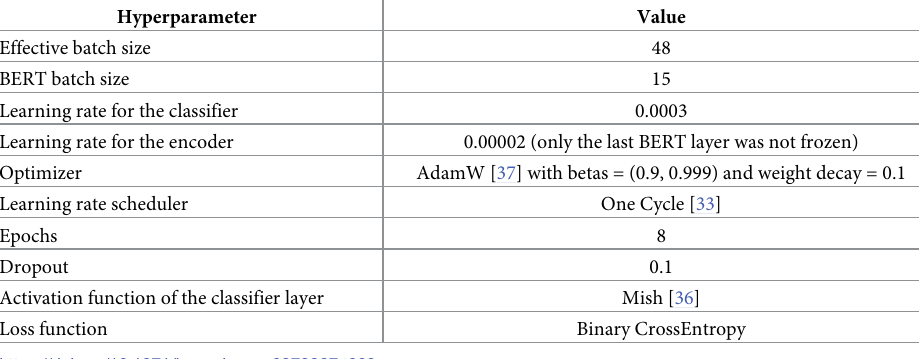
Table 3. Hyperparameters for the BERT + LSTM classifier.